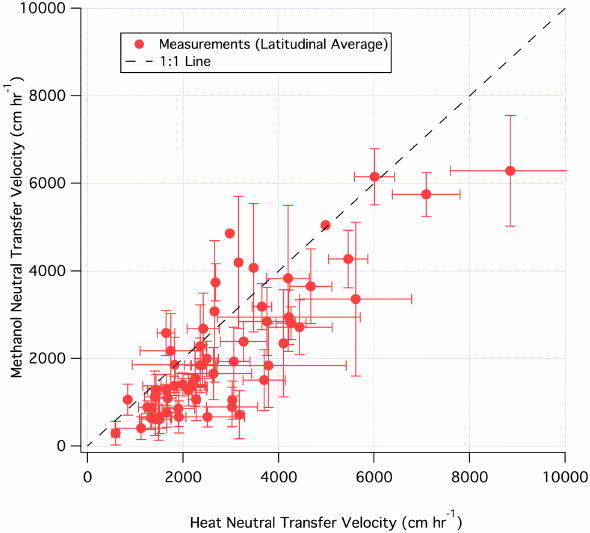
Figure 10. Methanol transfer velocity vs. heat transfer velocity in latitudinal bins (error bars indicate standard errors). Methanol trans- fer velocity was ∼ 85% of the heat transfer velocity, consistent with the lower diffusivity (higher Schmidt number) of methanol than heat in air.